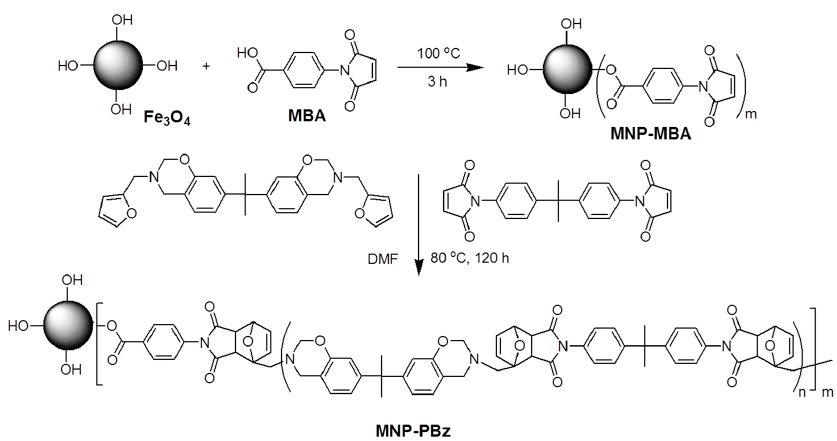
Figure 6. Preparation of Fe 3 O 4 NPs/polybenzoxazine grafts via DA reaction. Adapted with permission from [109]. Copyright © 2016 by WILEY-VCH Verlag GmbH & Co.